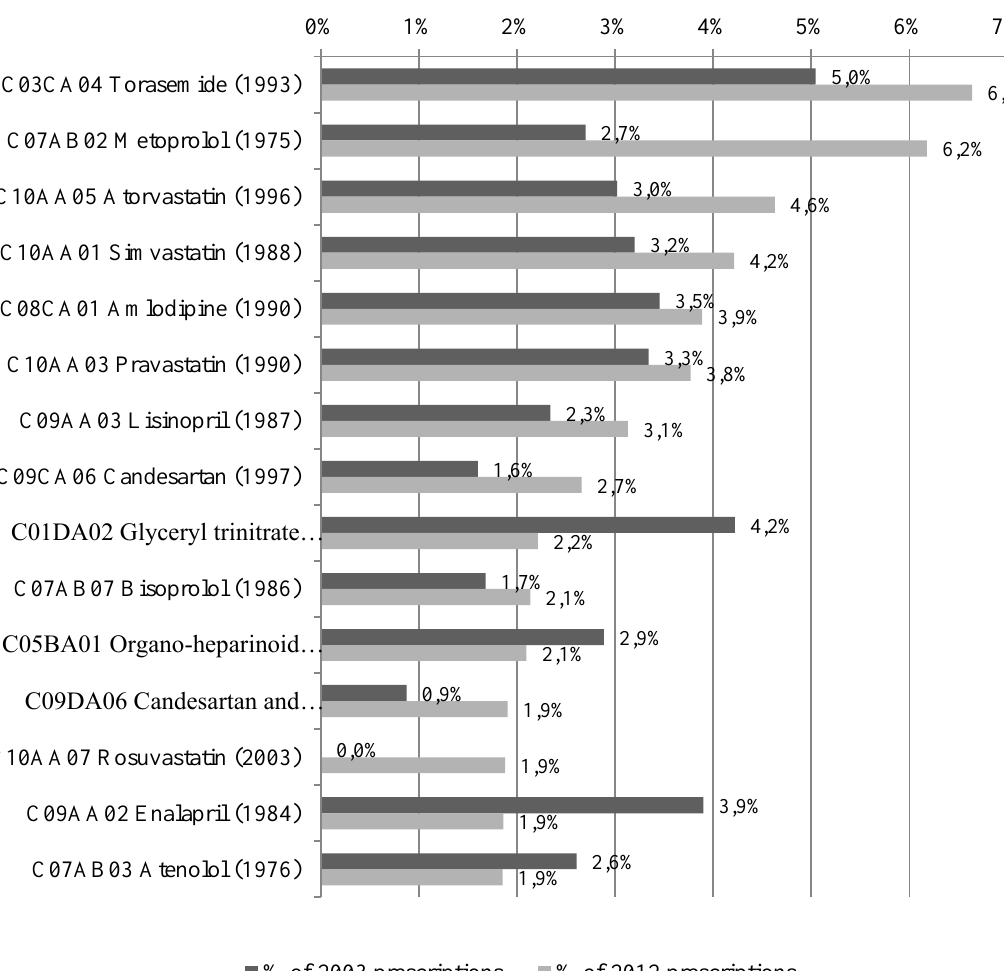
Figure 1: Shares of 2003 and 2012 prescriptions of top 15 cardiovascular system drugs, ranked by number of prescriptions in